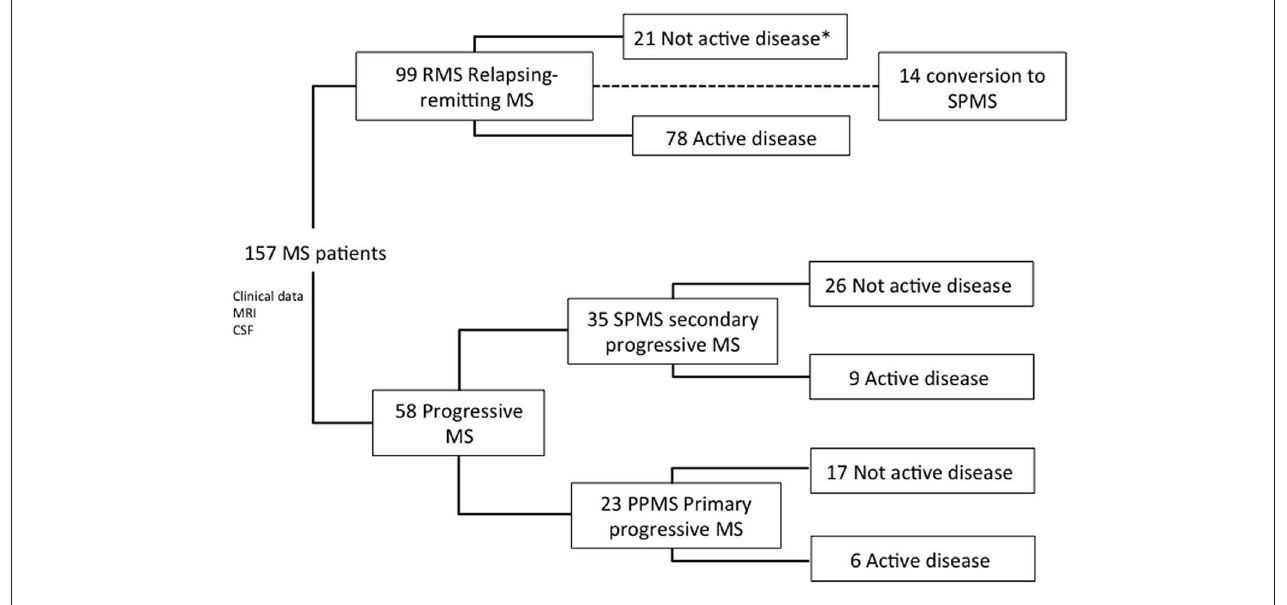
FIGURE 1 | Flow chart of study